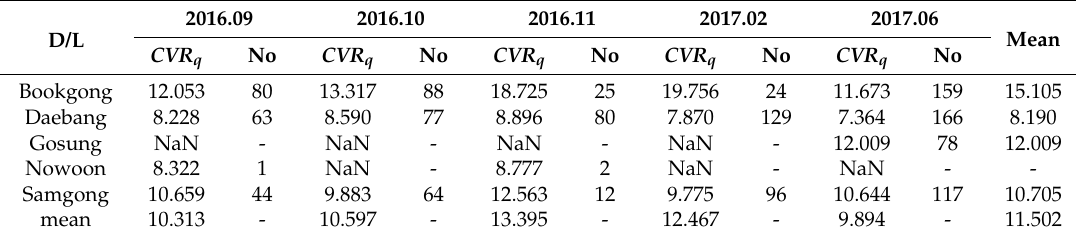
Table 8. CVR factor of the reactive power of the Chimsan substation (MAD direct method).